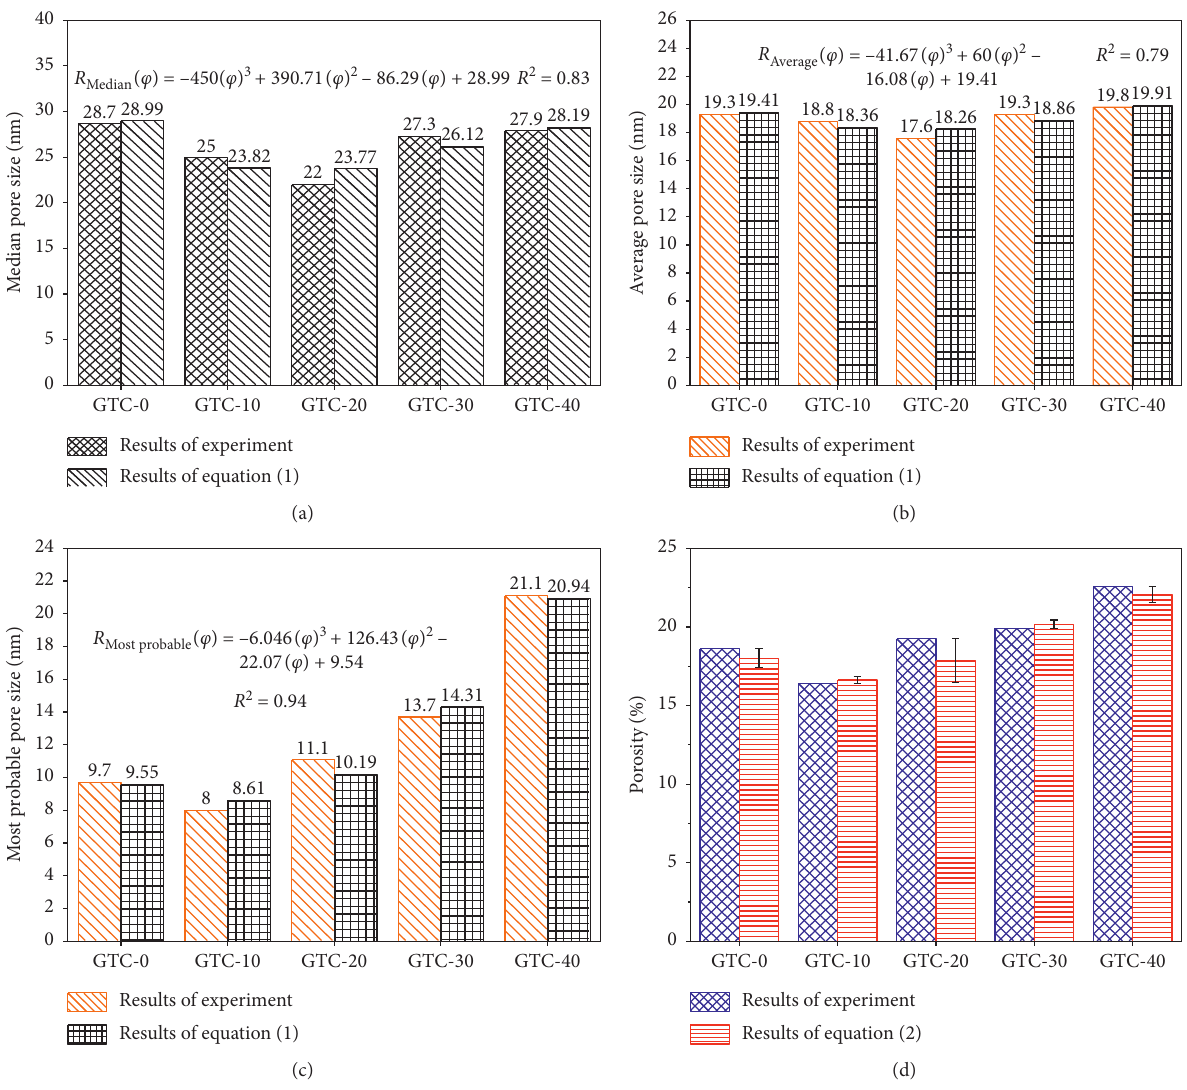
Figure 14: Analysis of pore structure characteristics on GTC (0% to 40%). (a) Median pore size; (b) average pore size; (c) most probable pore size; (d)